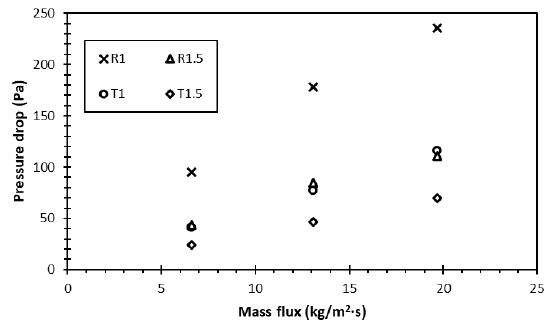
Figure 8. Pressure drops among four different surfaces.